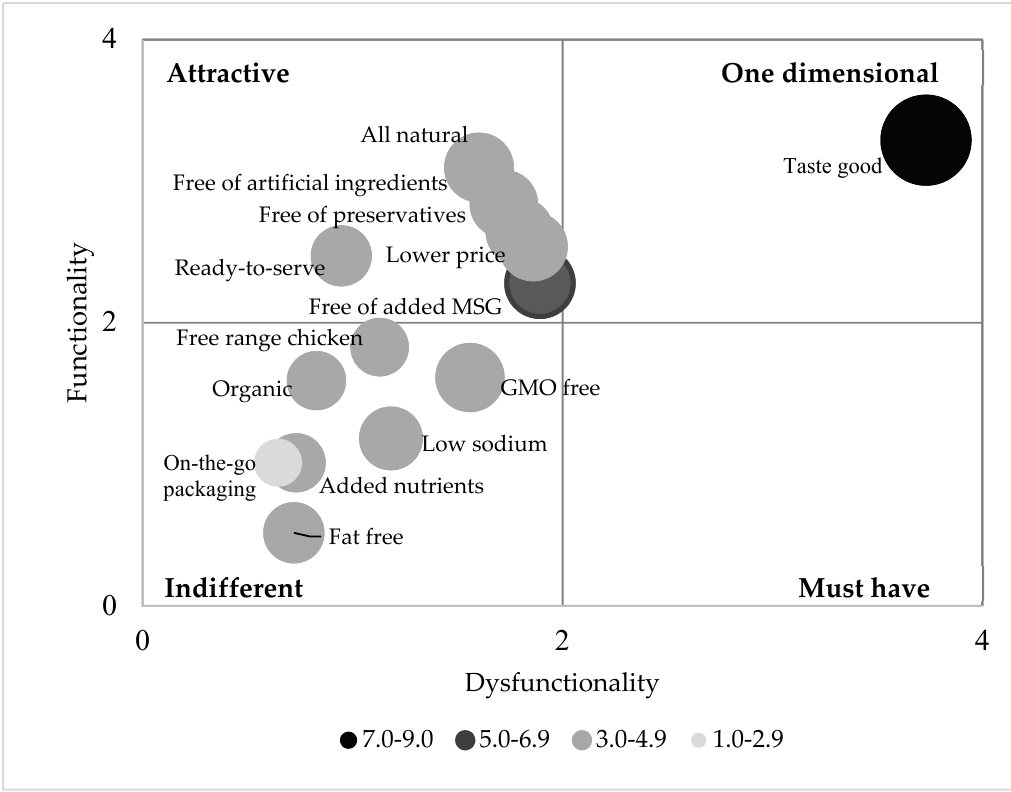
Figure 3. Kano classifications for 14 features about chicken soup products with averaged importance for each attribute indicated by size and color of the bubble.